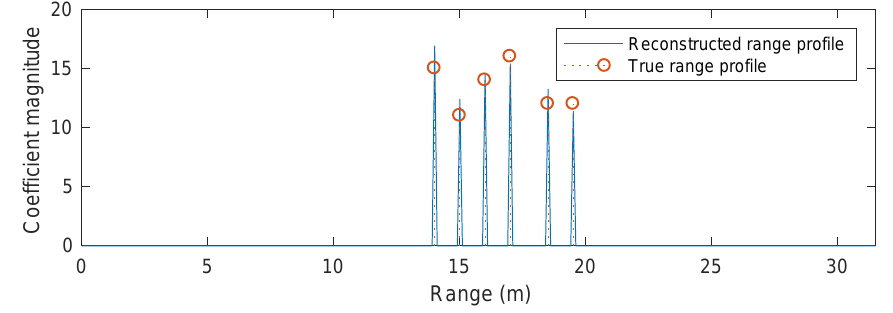
Figure 4. Performance of POMP in the presence of phase